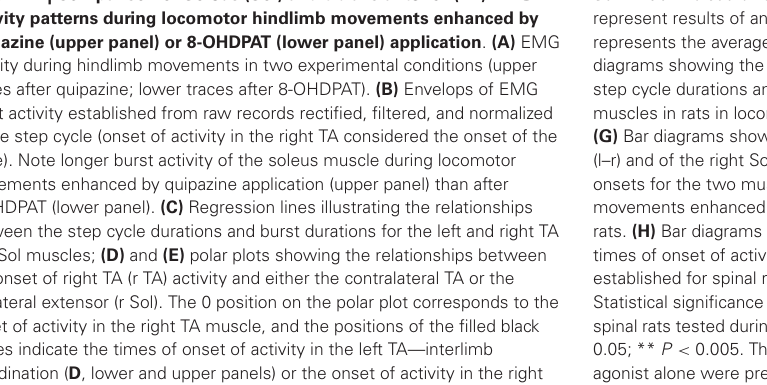
FIGURE 2 | Comparison of Soleus (Sol) and tibialis anterior (TA) EMG activity patterns during locomotor hindlimb movements enhanced by quipazine (upper panel) or 8-OHDPAT (lower panel) application . (A) EMG activity during hindlimb movements in two experimental conditions (upper traces after quipazine; lower traces after 8-OHDPAT). (B) Envelops of EMG burst activity established from raw records rectified, filtered, and normalized to the step cycle (onset of activity in the right TA considered the onset of the cycle). Note longer burst activity of the soleus muscle during locomotor movements enhanced by quipazine application (upper panel) than after 8-OHDPAT (lower panel). (C) Regression lines illustrating the relationships between the step cycle durations and burst durations for the left and right TA and Sol muscles; (D) and (E) polar plots showing the relationships between the onset of right TA (r TA) activity and either the contralateral TA or the ipsilateral extensor (r Sol). The 0 position on the polar plot corresponds to the onset of activity in the right TA muscle, and the positions of the filled black circles indicate the times of onset of activity in the left TA—interlimb coordination ( D , lower and upper panels) or the onset of activity in the right